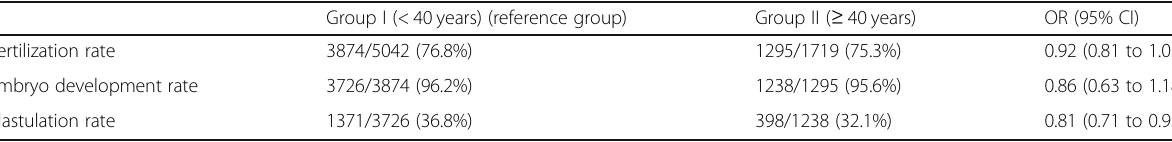
Table 3 Comparison of laboratory outcomes between group I (male partner age < 40 years) and group II (male partner ≥ years)